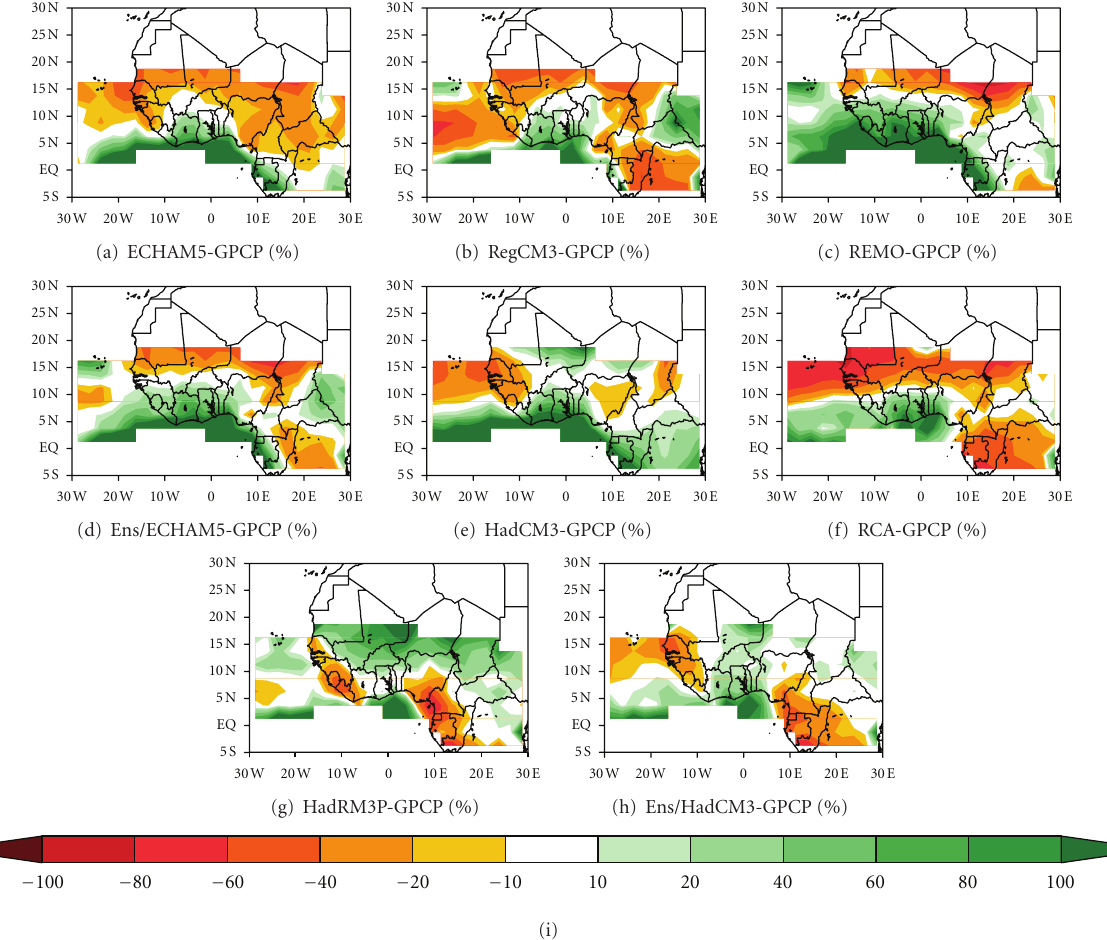
Figure 5: 1981–2000 averaged JJAS precipitation bias (in %) for (a) ECHAM5, (b) RegCM3, (c) REMO, (d) Ens/CHAM5 (ensemble mean of RCMs driven by ECHAM5), (e) HadCM3, (f) RCA, (g) HadRM3P, and (h) Ens/HadCM3 (ensemble mean of RCMs driven by HadCM3) with respect to GPCP.